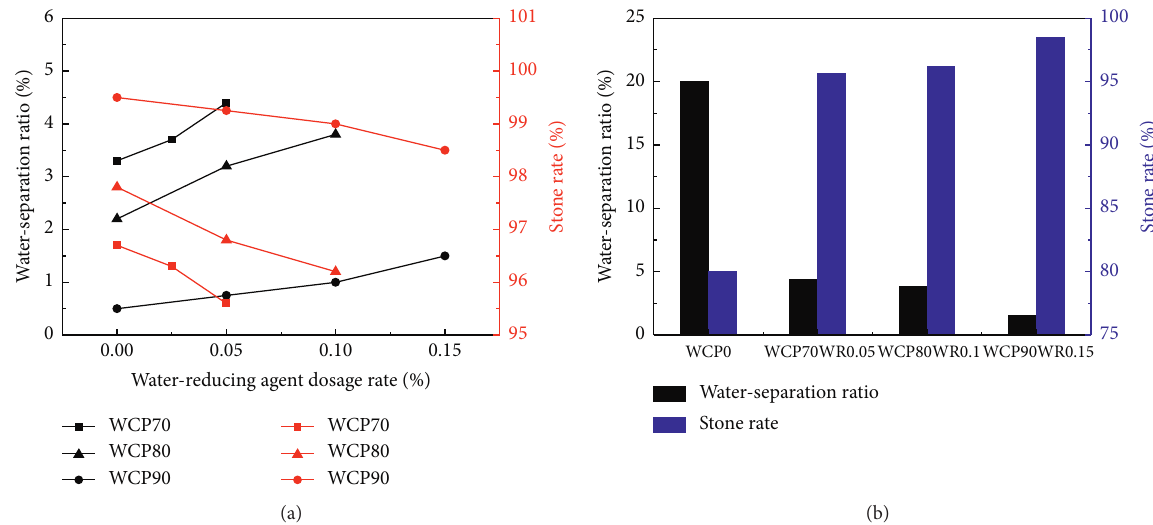
Figure 10: Water-separation ratio and stone rate after adding water-reducing agent: (a) change rule and (b) comparison of slurries with similar viscosity.